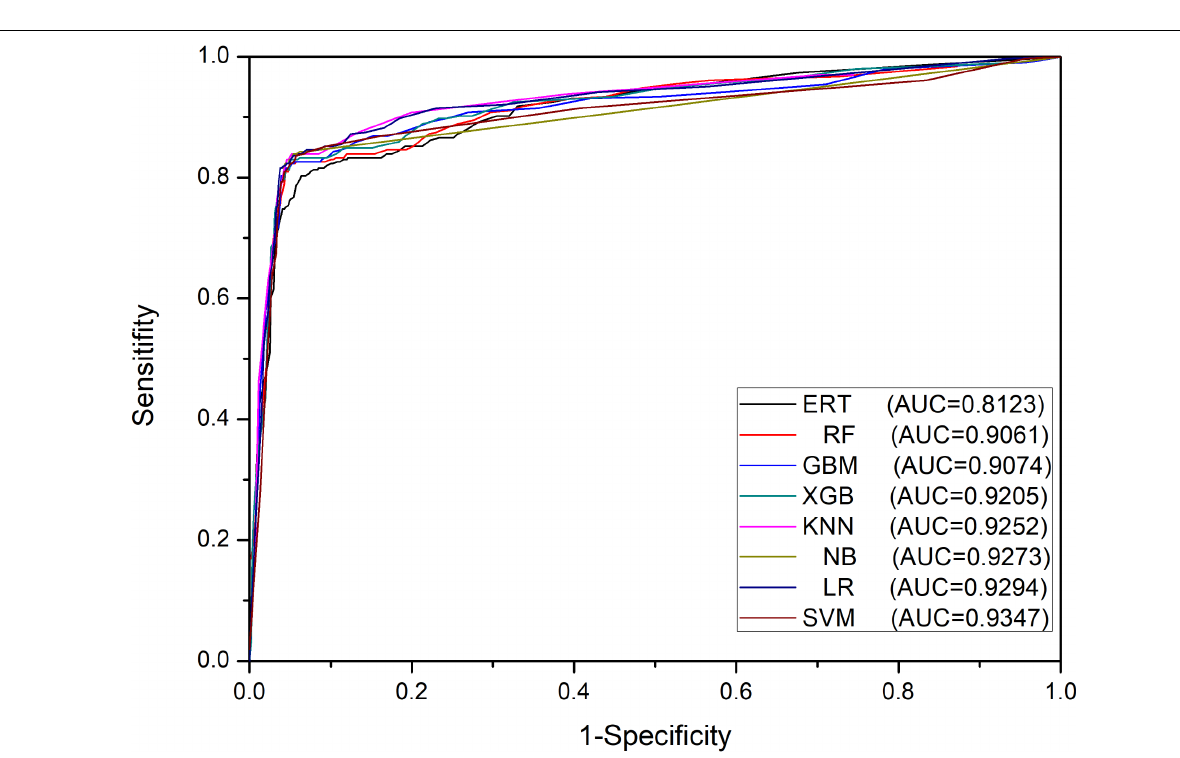
Frontiers in Microbiology |